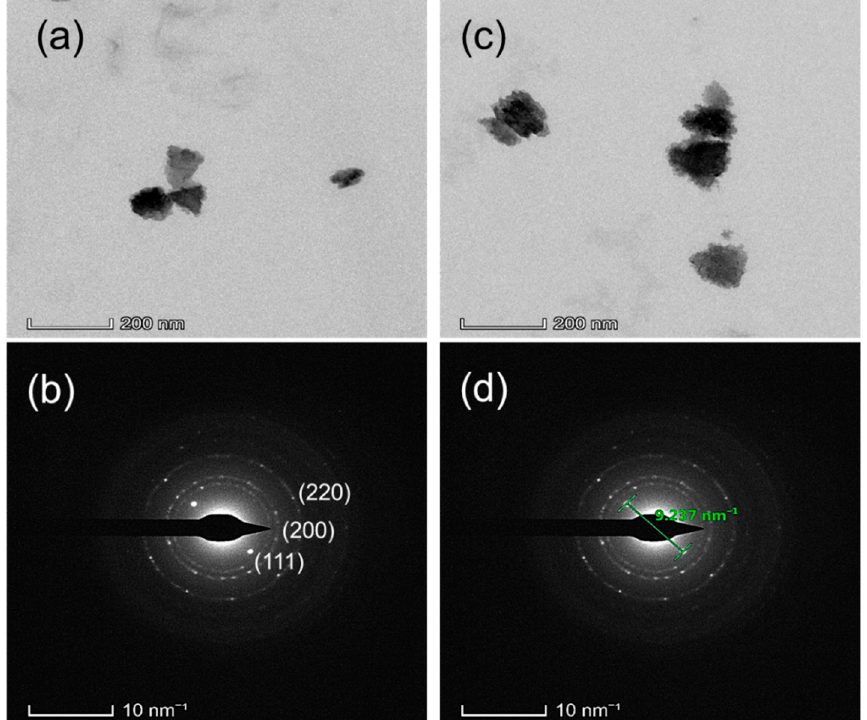
Figure 5. TEM and SAED images of PbS nanoparticles synthesized via plant-extract supported method, ( a ) and ( b ) are for 300 °C, and ( c ) and ( d ) is for 360 °C of calcination temperature.